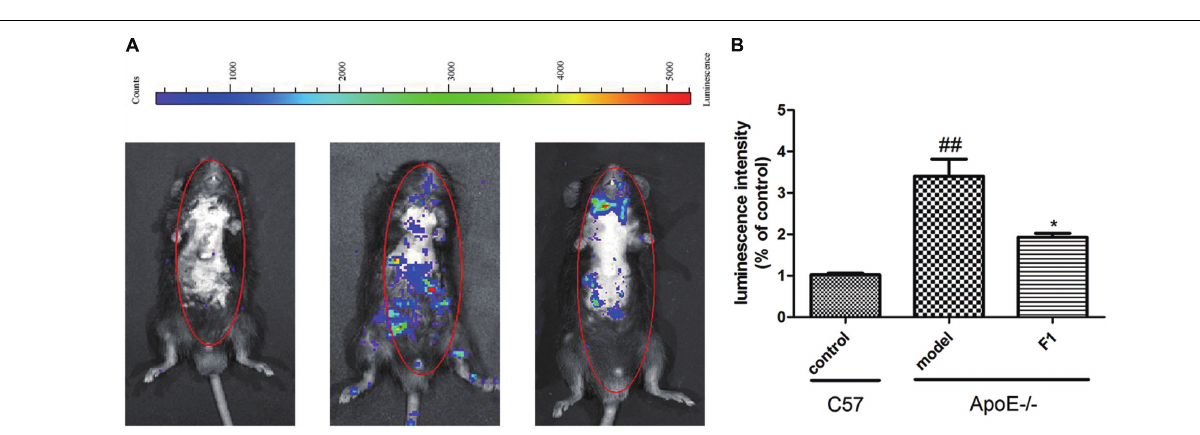
Frontiers in Pharmacology | www.frontiersin.org